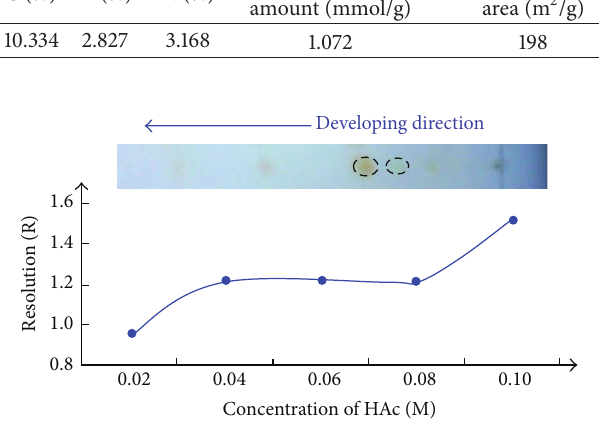
Figure 5: Effect of HAc concentration on resolution (L: berberine hydrochloride, R: tetrahydropalmatine, and developing distance = 8